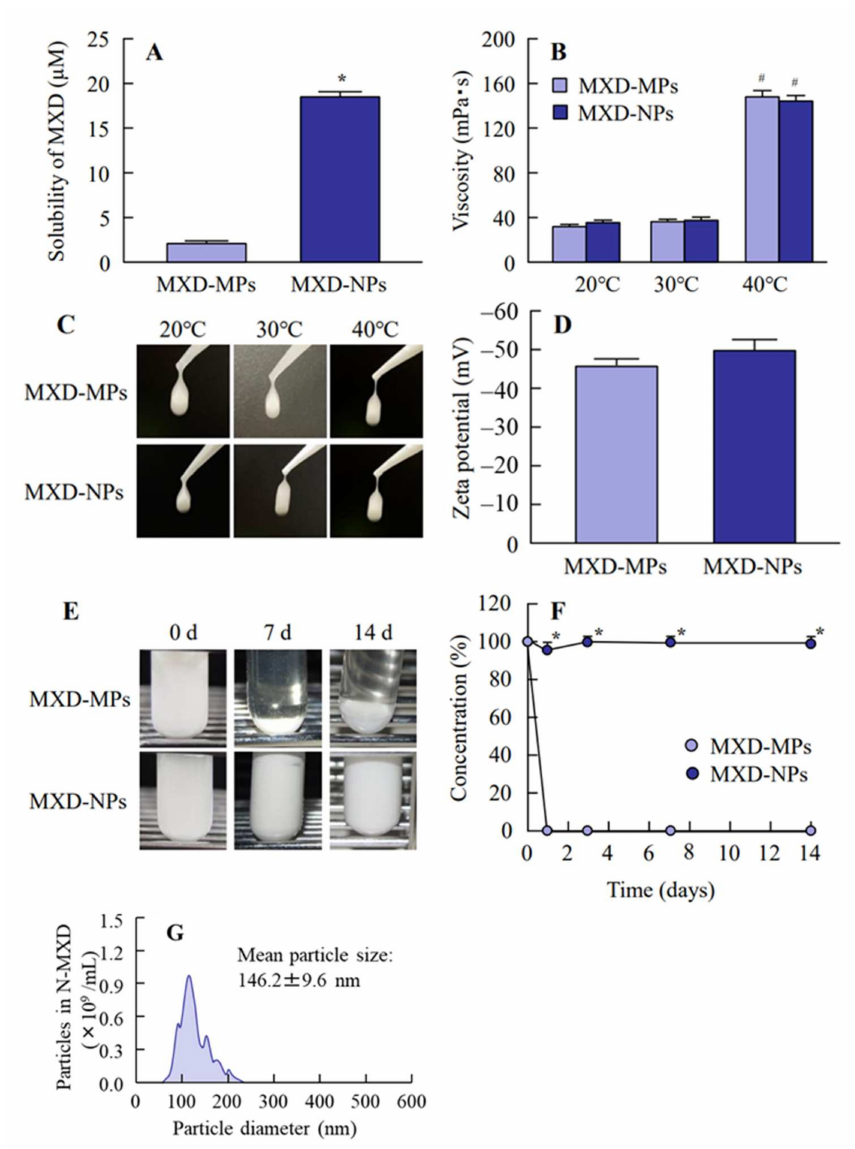
Figure 2. Solubility, viscosity, zeta potential and dispersibility of MXD-MPs and MXD-NPs. ( A ) Solubility of MXD in MXD-MPs and MXD-NPs. ( B ) Viscosity of MXD-MPs and MXD-NPs. ( C ) Images of MXD-MPs and MXD-NPs at 20–40 ◦ C. ( D ) Zeta potential of MXD-MPs and MXD-NPs, ( E ) and ( F ) Images ( E ) and dispersibility ( F ) of MXD-MPs and MXD-NPs. ( G ) Particle size distribution of MXD-NPs after the 14-d incubation. n = 7. * p < 0.05 vs. MXD-MPs. # p < 0.05 vs. MXD-MPs at 20 ◦ C for each category. The solubility of the MXD-NPs was 8.76-fold that of the MXD-NPs, and over 99% of the MXD was solid MXD in the MXD-NPs. The viscosity was enhanced at 40 ◦ C, and no aggregation was observed for 14 d in the